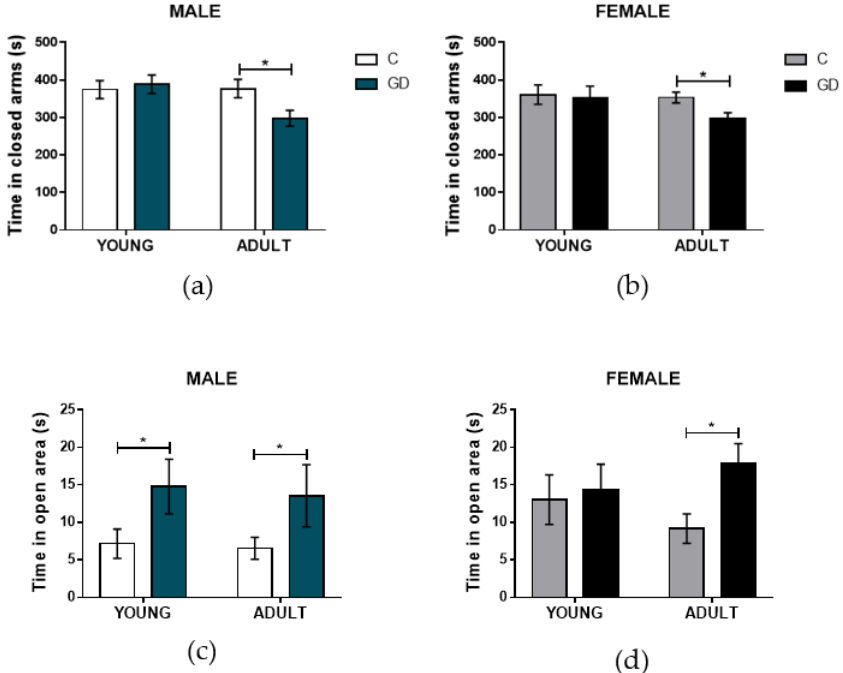
Figure 1. E ff ect of gestational diabetes (GD) on anxiety-like o ff spring behavior. Time spent in closed Figure 1. Effect of gestational diabetes (GD) on anxiety-like offspring behavior. Time spent in closed arms of the elevated plus maze for the ( a ) male and ( b ) female o ff spring rats. Time spent in the open arms of the elevated plus maze for the ( a ) male and ( b ) female offspring rats. Time spent in the open area of the open field for the ( c ) male and ( d ) female o ff spring rats. C, control o ff spring; GD, gestational area of the open field for the ( c ) male and ( d ) female offspring rats. C, control offspring; GD, diabetes o ff spring. Control male o ff spring: young, n = 10; adult, n = 12; GD male o ff spring: young, n = 10; adult, n = 12. Control female o ff spring: young, n = 10; adult, n = 10; GD female o ff gestational diabetes offspring. Control male offspring: young, n = 10; adult, n = 12; GD male offspring: